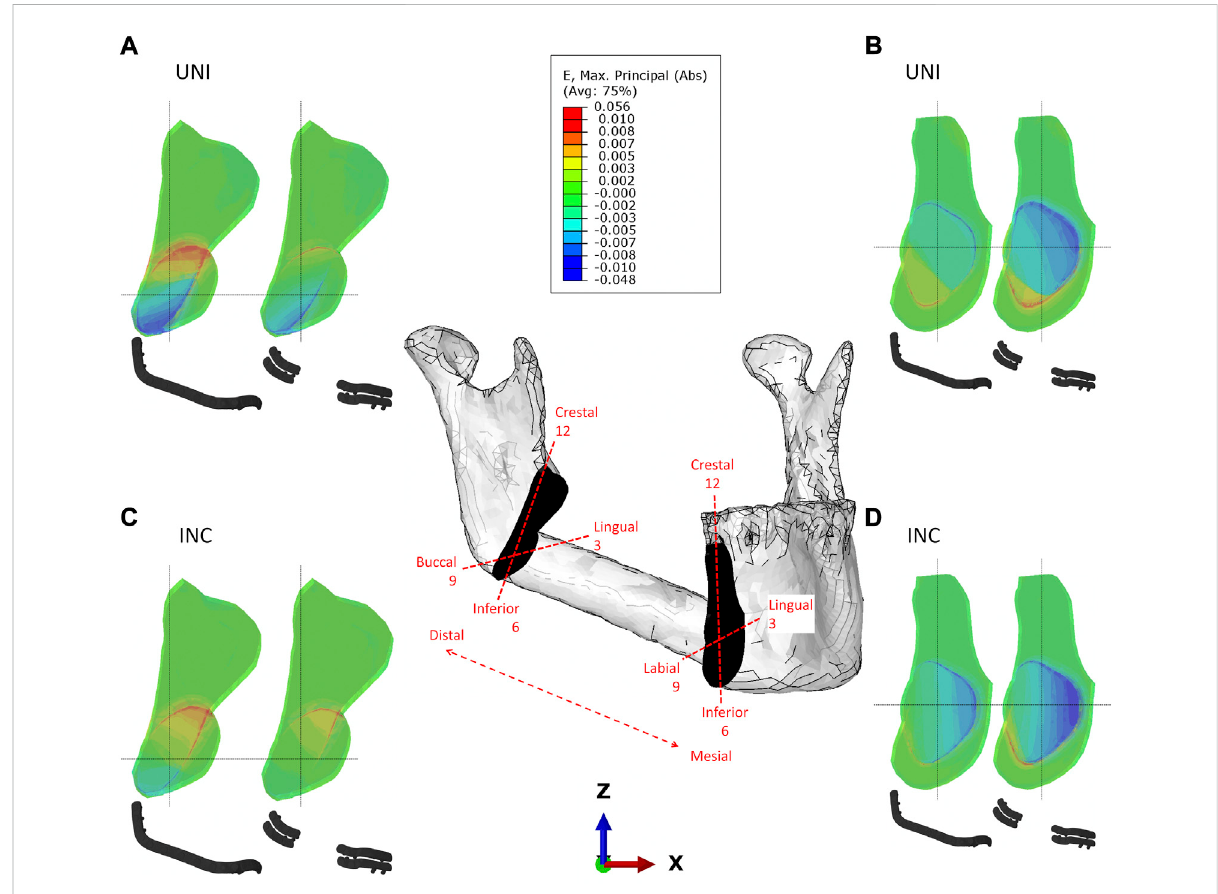
FIGURE 3 Straindistributioninthedistal (A – C) andmesial (B – D) intersegmentalgapforreconstructionplateandminiplate fi xationinbitingtasksunilateral (UNI) and incisal (INC) biting.